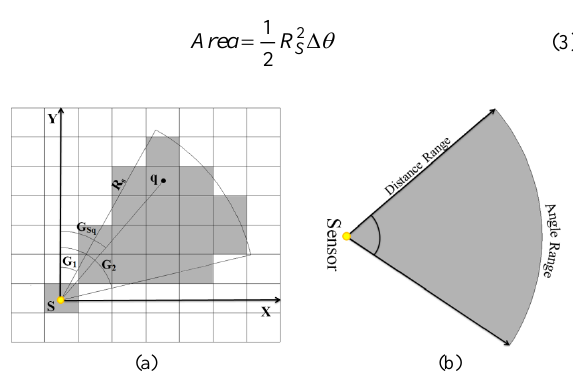
Figure 1. 2D coverage estimation: (a) raster model (gray pixels are covered by the sensor S); (b) vector model (gray region is covered by the sensor S)